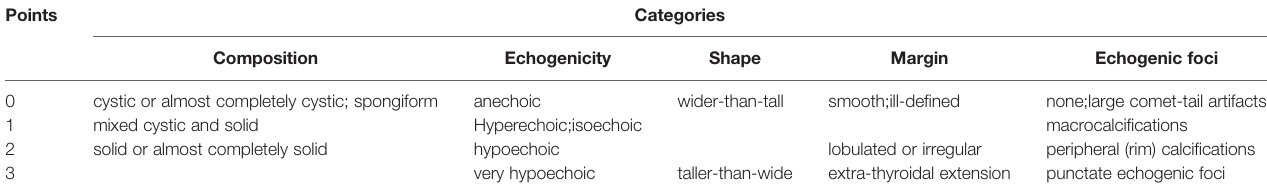
TABLE 1 | Point system in ACR TI-RADS